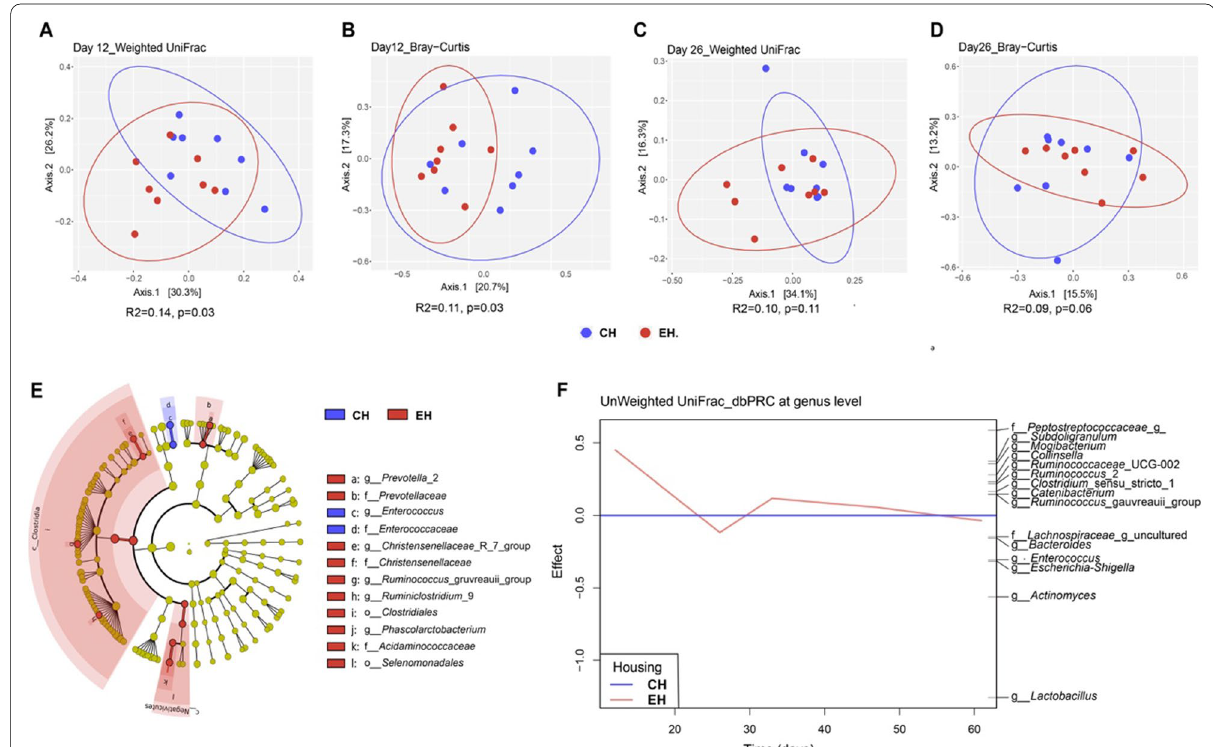
Fig. 4 The effect of housing condition on microbiota colonization. Principal coordinate analysis (PCoA) plots based on pairwise weighted UniFrac distance and Bray–Curtis dissimilarity matrices using data from day 12 ( A , B ) and day 26 ( C , D ) at amplicon sequence variant (ASV)‑level. Significance of the difference between conventional housing (CH) and enriched housing (EH) was assessed using PERMANOVA. E Cladogram of taxa differentially abundant between CH and EH pigs on day12 according to LEfSe. The color indicates the difference between both housing types in which the taxa were more abundant and the radius of each shaded sector is corresponding to the relative abundance. F Unweighted UniFrac based principal response curve (dbPRC) summarizing the multivariate response of EH versus CH at genus level over time. Genera with large deviations between CH and EH have high effect while taxa equally present in CH and EH have zero